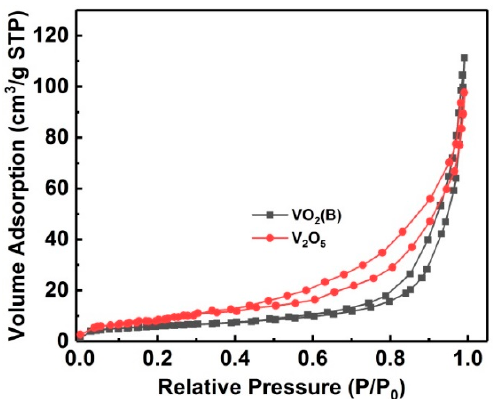
Figure 5. N 2 adsorption–desorption isotherms of self-assembled VO 2 (B) and V 2 O 5 nanoflakes.